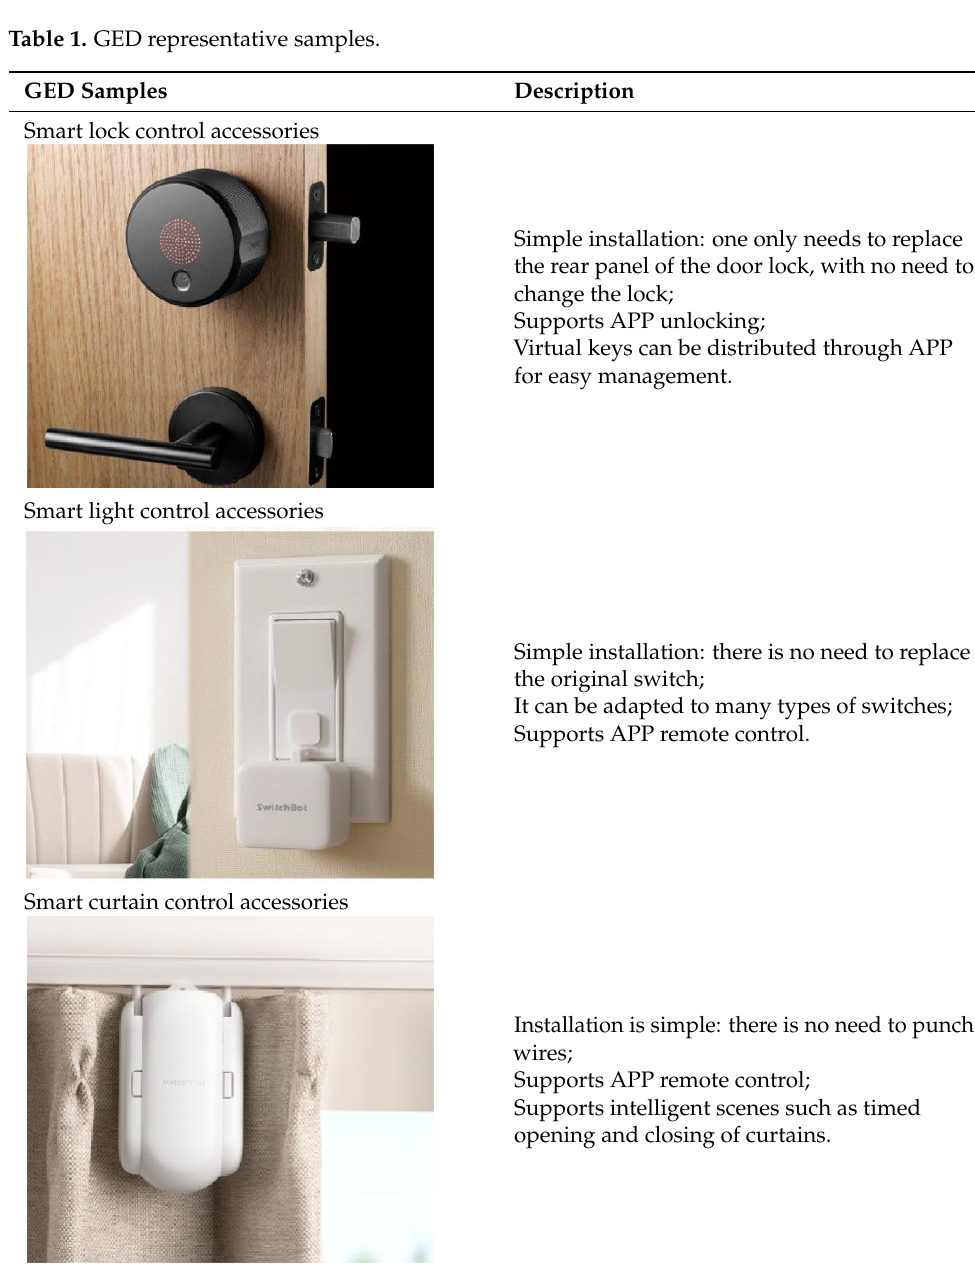
Table 2. Online reviews derived from GED samples.